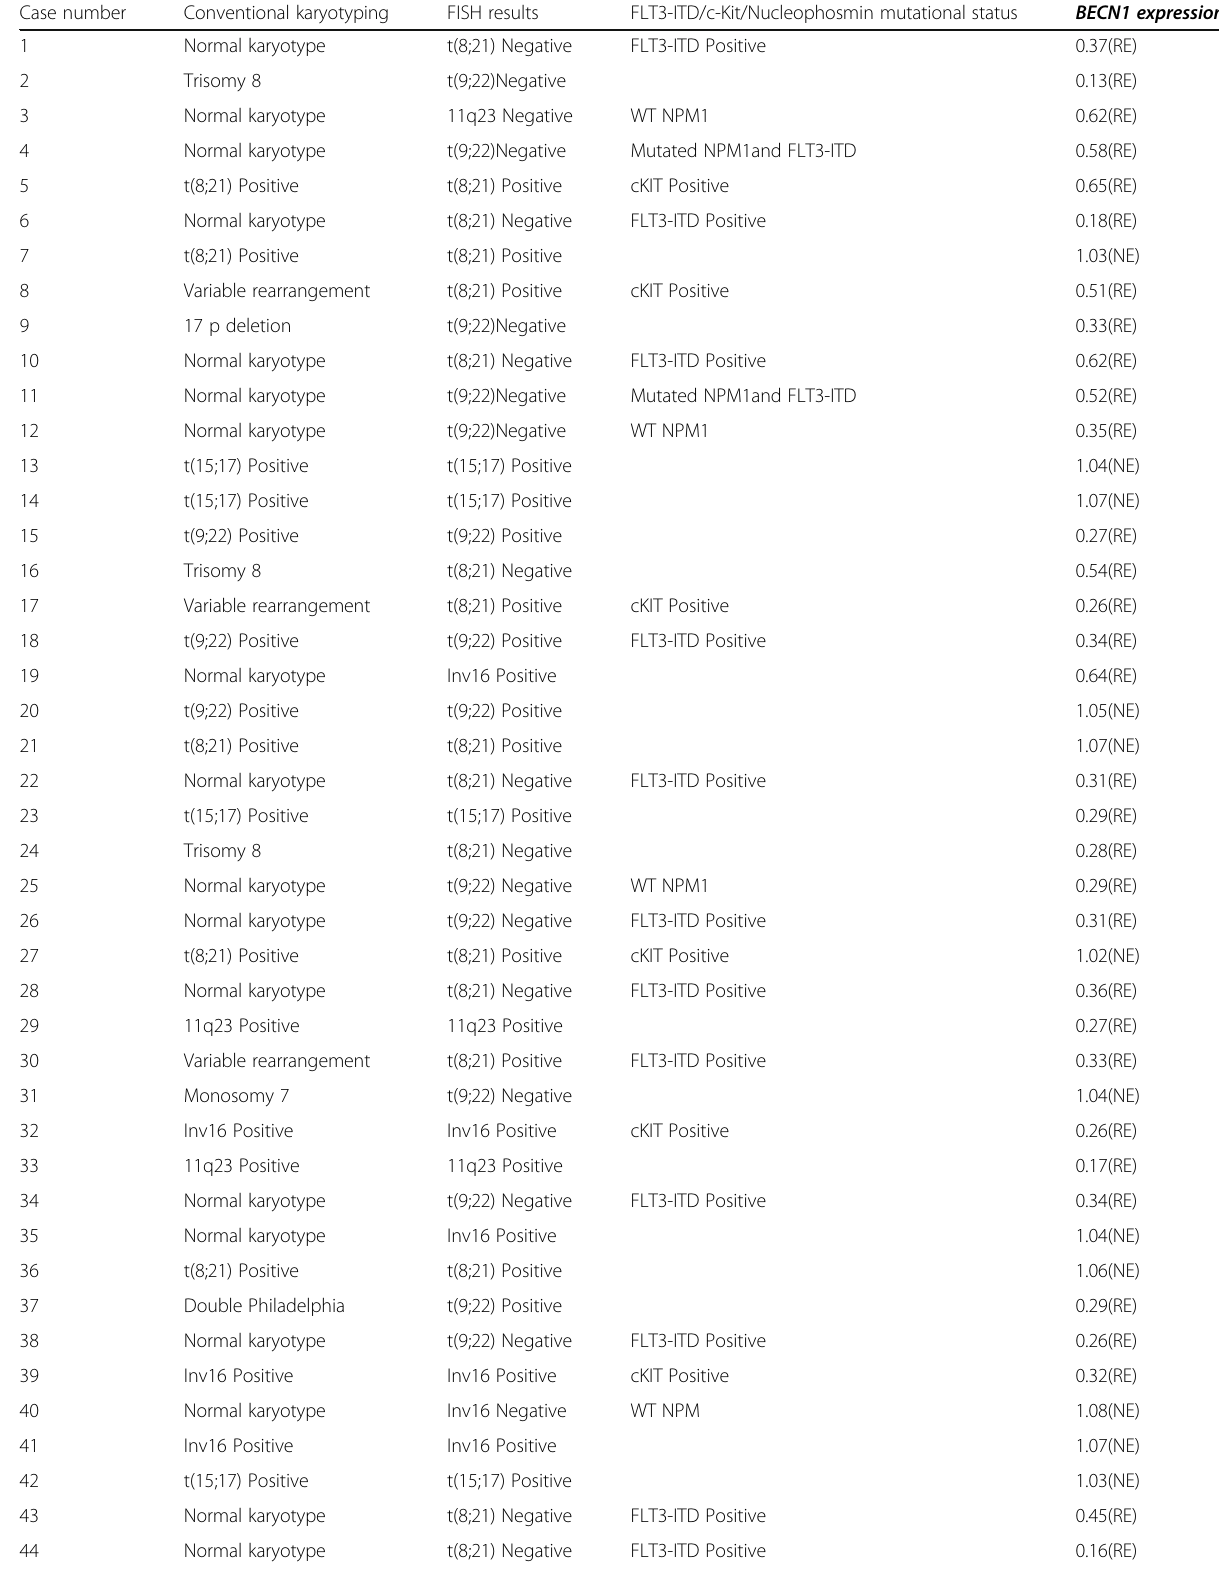
Table 2 Results of karyotyping, FISH analysis, mutational screening and BECN1